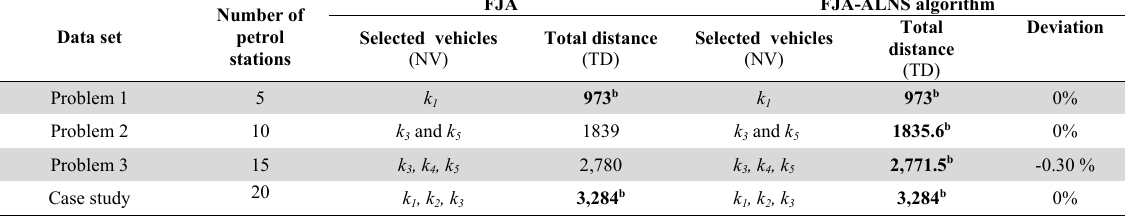
Comparison of solutions using the FJA and the proposed FJA-ALNS algorithm